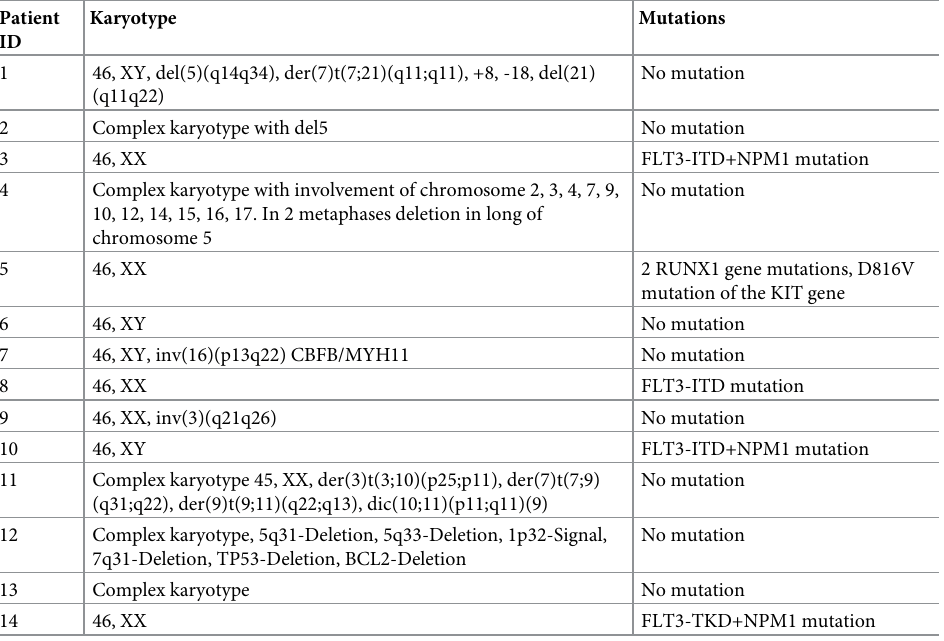
Table 4. Cytogenetic und molecular information in AML patients with blast vacuolization.